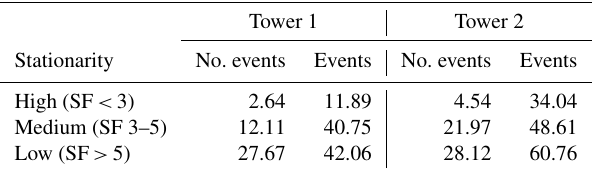
Table A2. Deviations between 30min averaged fluxes based on wavelet and EC processing, expressed as the root-mean-square error (nmolm − 2 s − 1 ). Time series include gap-filled values from linear interpolation for the EC time